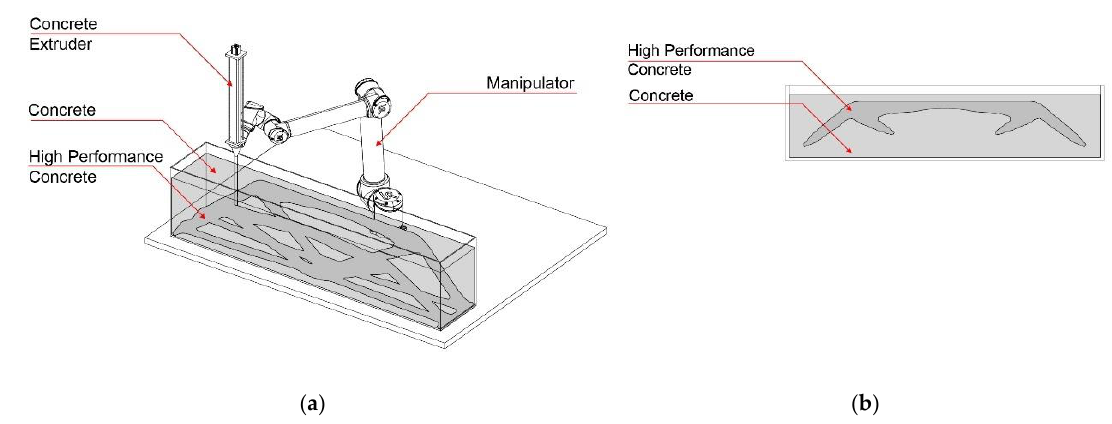
Figure 3. Concrete in Concrete (CiC): ( a ) fabrication process diagram; ( b ) section through a locally strengthened element.